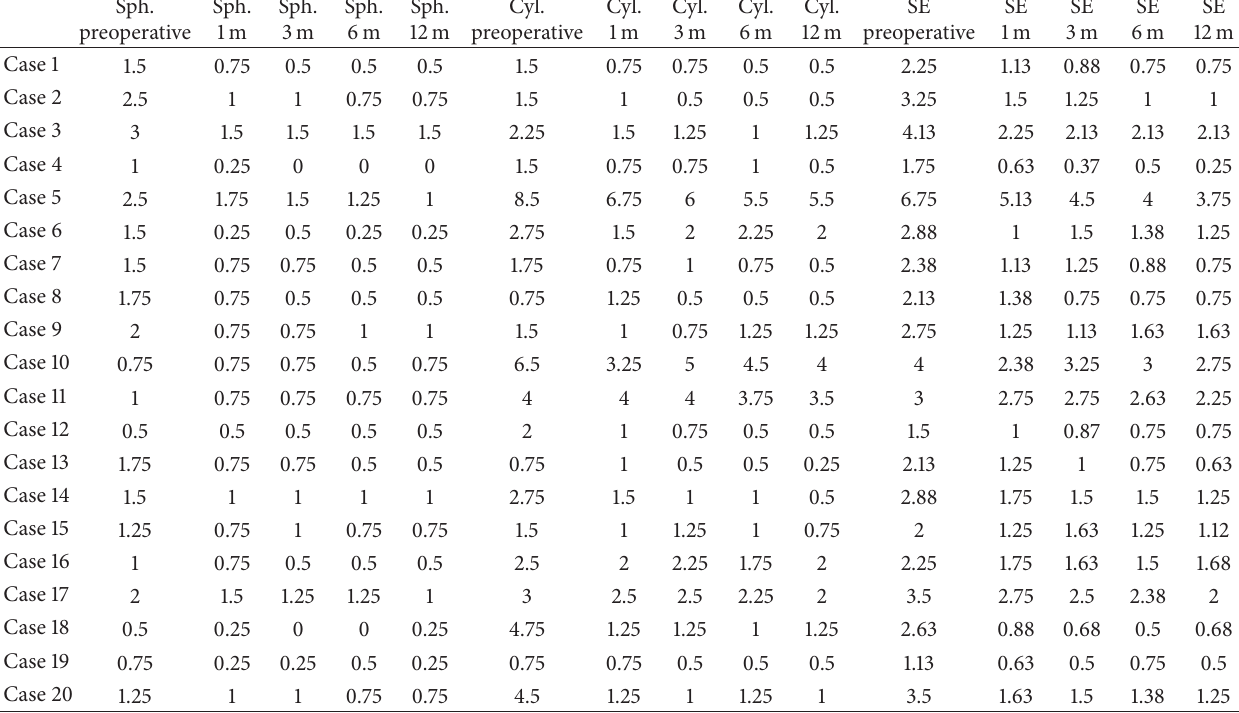
Table 2: Pre- and postoperative sphere, cylindrical and spherical equivalent